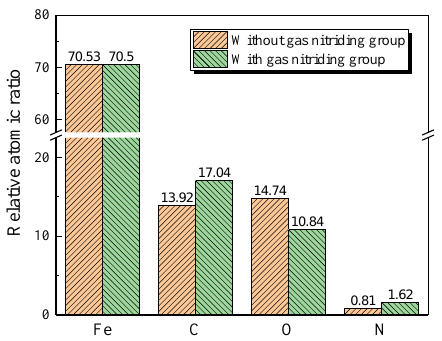
Figure 11. Relative atomic ratio of main element.